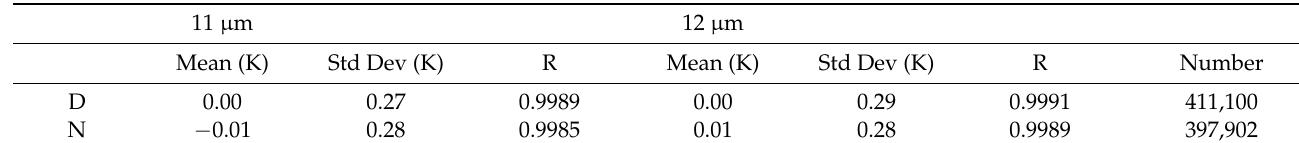
Table 5. DD between VIRR_COR and MODIS_BT (D means daytime, N means nighttime, R means correlation coefficient).